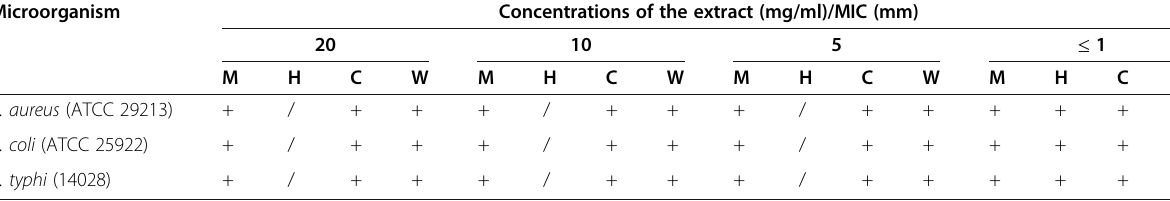
Table 1 Minimum inhibitory concentration (MIC) of B. senegalensis on the test bacteria